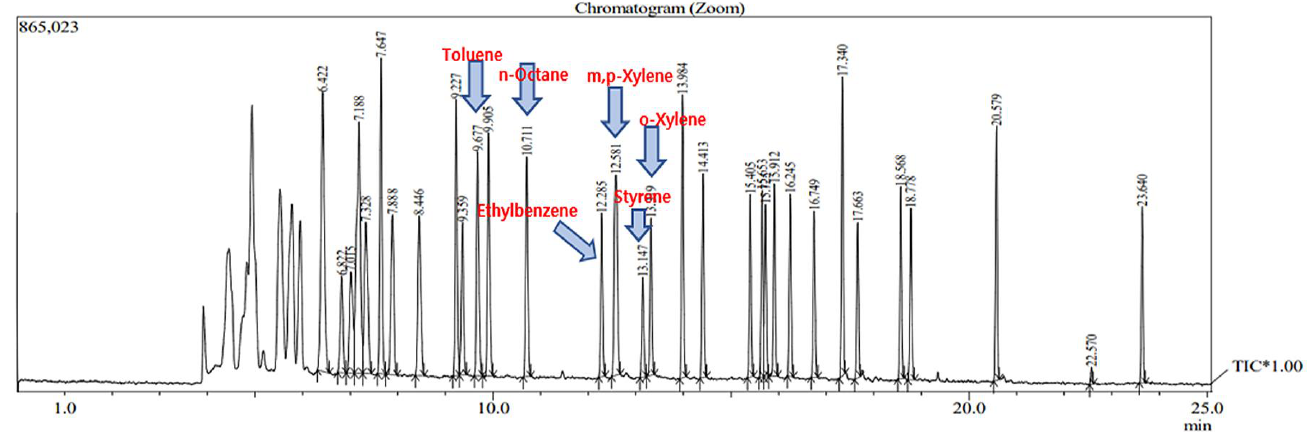
Figure 7. Chromatogram of blank analysis.